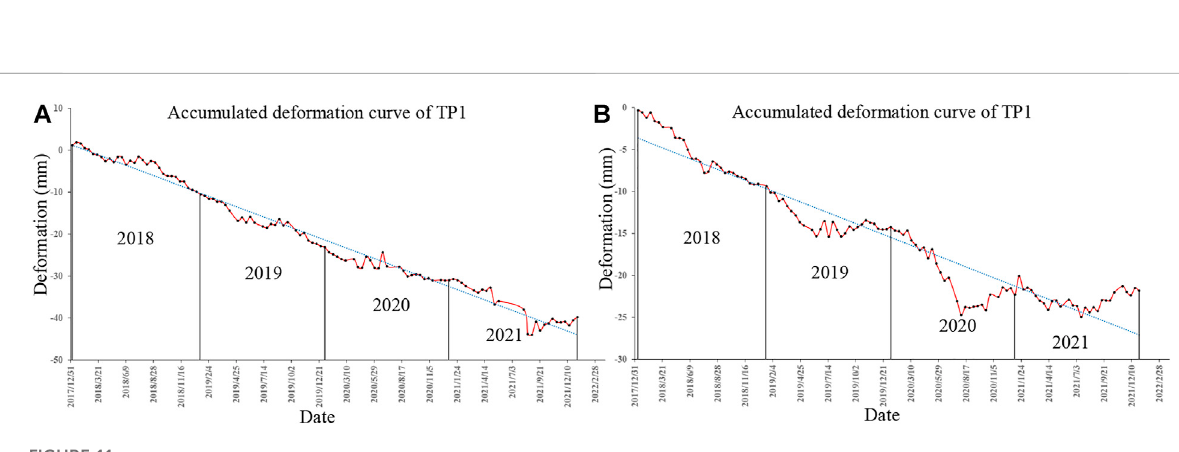
FIGURE 11 Time series deformation of TP1 on the QGE. (A) and (B) indicate the ascending and descending results,